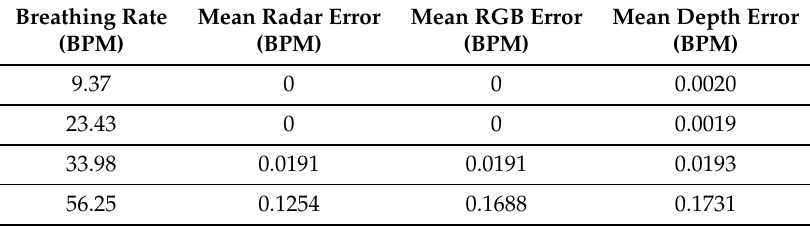
Table 4. Signal fidelity experimental